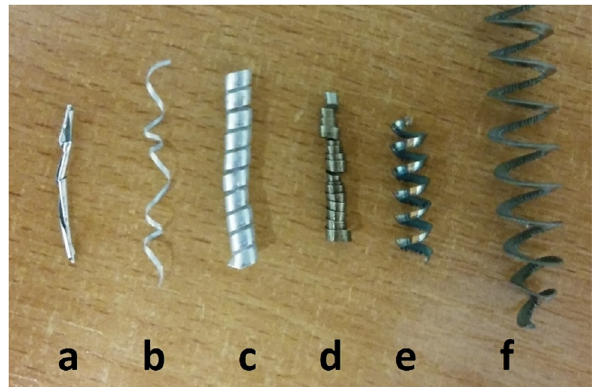
Figure 1: A view of the chips used during the research ( a ) titanium fi ne chip ( TFC ) , ( b ) aluminium fi ne chip ( AFC ) , ( c ) aluminium medium chip ( AMC ) , ( d ) steel fi ne chip ( SFC ) , ( e ) steel medium chip ( SMC ) , ( f ) steel thick chip ( STC